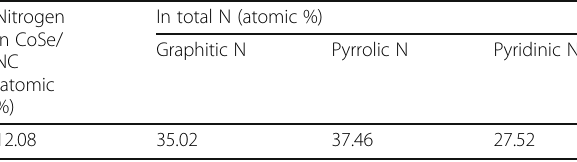
Table 1 Percentage of nitrogen in CoSe/NC and different types of N in total